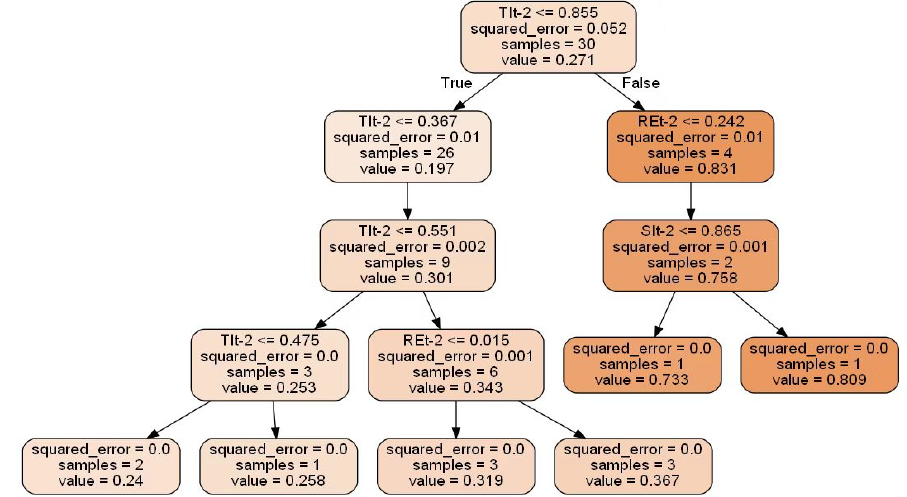
Figure 7. Decision tree generation in pattern 1.